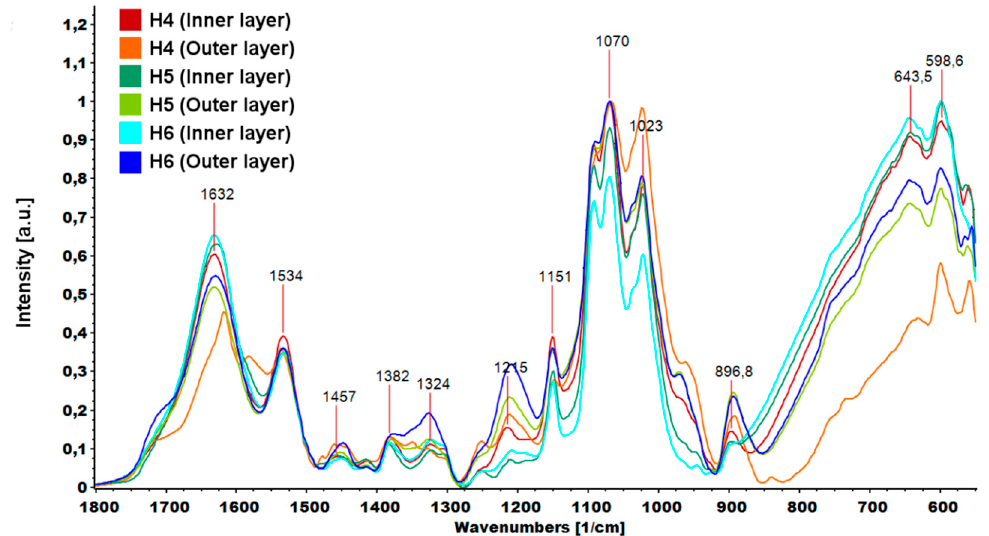
Figure 9. Parts of FTIR (Fourier transform infrared spectroscopy) spectra of hydrogels (H4: chitosan (CS) / graphene oxide (GO) / hydroxyapatite (HAp); H5: CS / poly(ethylene glycol) grafted graphene oxide / HAp; H6: CS / reduced graphene oxide / HAp) in the range 1800–550 cm − 1 .